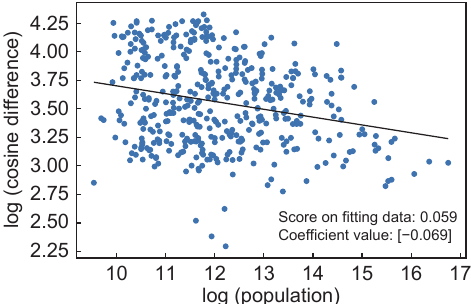
Fig. 8 log-log plot of the cosine distances between the vectors for MSAs and the center of mass for research.